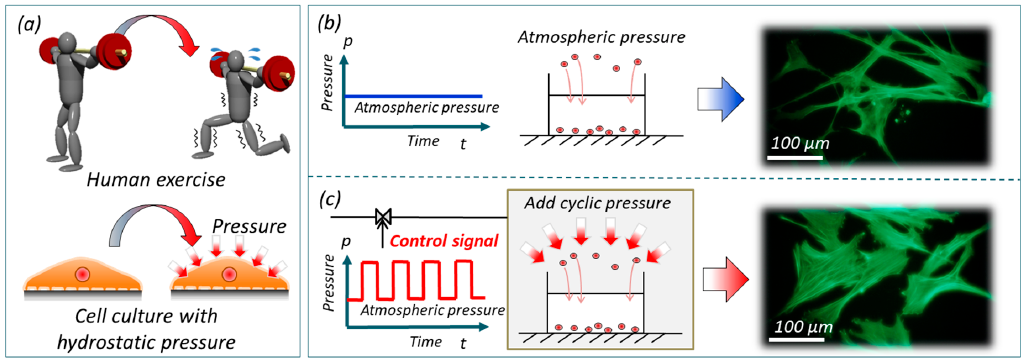
Figure 1. An overview of Periodic hydrostatic pressure. ( a ) The analogy of Periodic hydrostatic pressure to human exercise. ( b ) Conventional cell culture and a result showing the stress fibers of the cultured human smooth muscle cells (HSMCs) under atmospheric pressure. ( c ) Cell culture with Periodic hydrostatic pressure and a result showing the stress fibers of the cultured HSMCs under periodic pressure. The stress fibers, the actin filaments, were stained with Acti-stain 488 Fluorescent